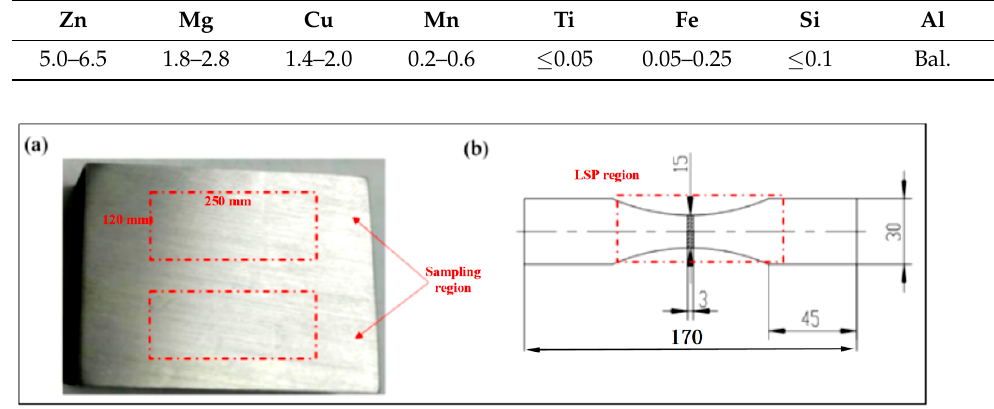
Figure 1. Diagram of the 7B04 aluminum alloy reinforcement area. ( a ) Position of the fatigue sample sampling; ( b ) size of the fatigue sample and the selection of the LSP region.